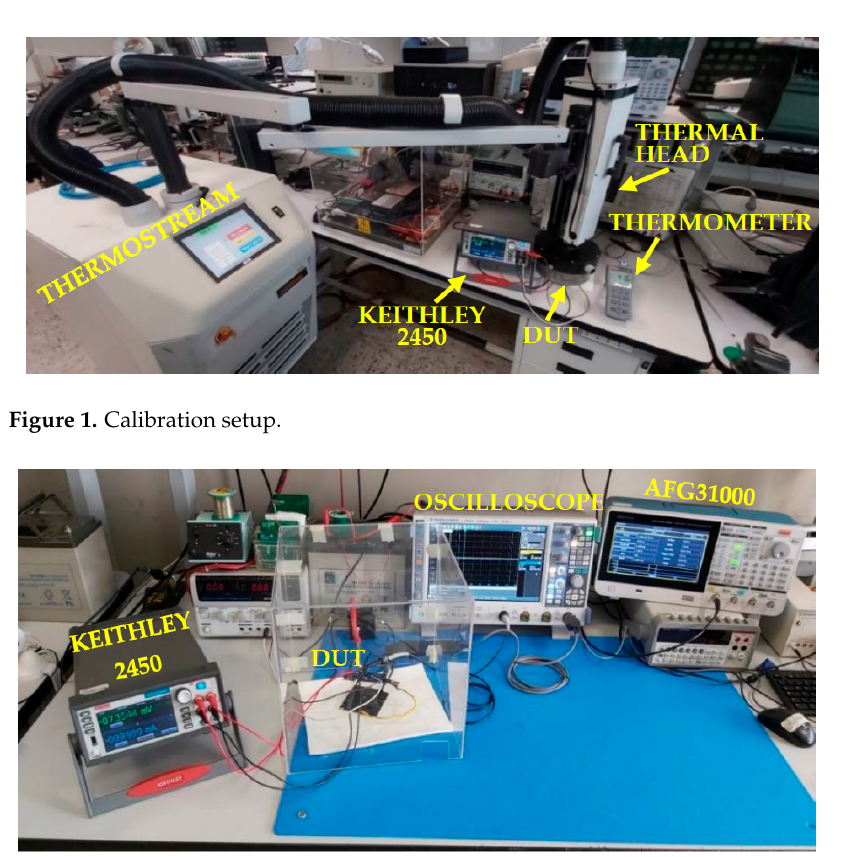
Figure 2. Measurement setup.